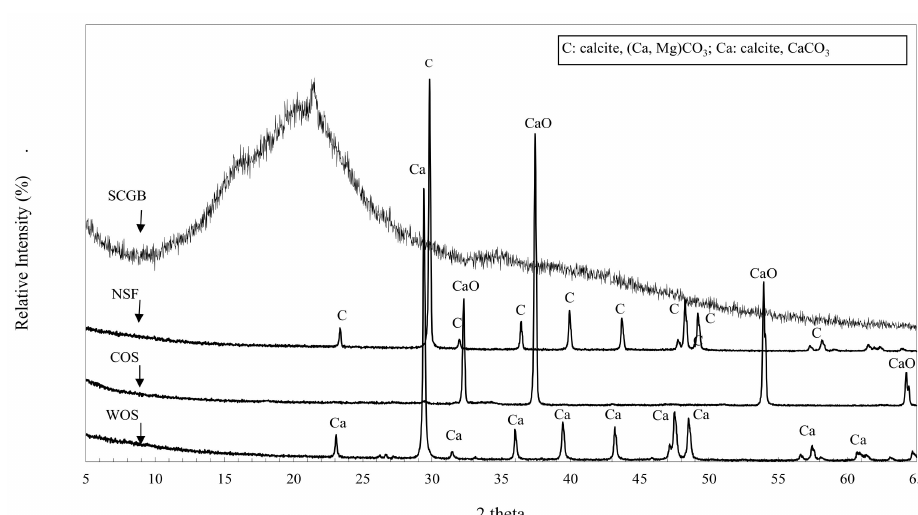
Figure 7. XRPD patterns for the waste oyster shells (WOS), calcined oyster shells (COS), natural starfish (NSF), and spent-coffee-grounds-derived biochar (SCGB). The XRPD results for the stabilizing agents indicate that a calcite (PDF# 47-1743, CaCO 3 ) was observed in the waste oyster shells (WOS) sample while a different type of calcite (PDF# 43-0697, (Ca, Mg)CO 3 ) was identified in the natural starfish (NSF) sample (Figure 7). This indicates that an Mg source, present in the NSF, does not exist in the WOS sample. Through the calcination process, which was conducted at 900 ◦ C for 2 h, the existing calcite (CaCO 3 ) in the WOS was completely transformed into quicklime (CaO) (PDF# 48-1467) in the calcined oyster shell (COS) sample (Figure 7). This indicates that the total decomposition of CaCO 3 was achieved at 900 ◦ C for 2 h. CaCO 3 can be trans- formed into CaO by a chemical decomposition reaction during the calcination process (Equation (1)).